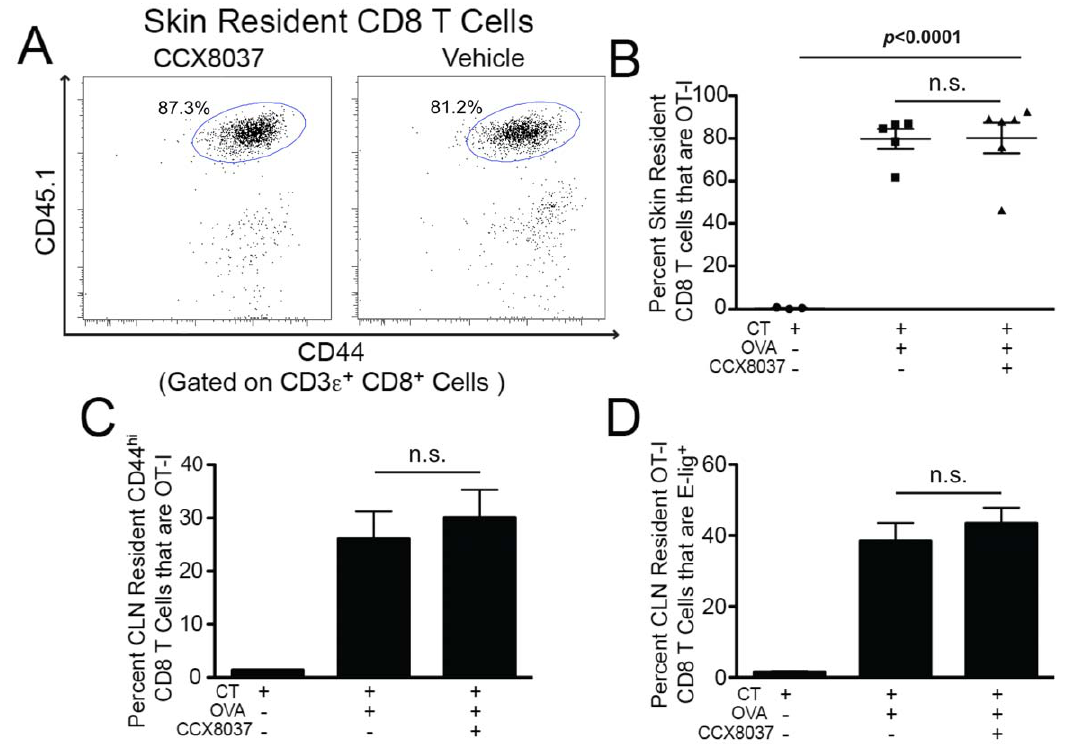
Figure 3. CCX8037 does NOT reduce accumulation of OT-I CD8 T cells in the skin. Animals were injected with 3e6 OT-I CD8 T cells, and epicutaneously immunized 24 hours later on the ear skin. Ear skin was painted with either 100 m g Cholera Toxin (CT) only, or 100 m g CT + 100 m g OVA 257–264 . Animals treated with OVA 257–264 were split into two groups and received subcut. injections of CCX8037 or vehicle every 12 hours for the course of the study. Mice were sacrificed for analysis 5 days post immunization. Mean and SEM shown for each data point, p values indicate Bonferroni multiple comparison post test. (A) Representative flow cytometry plot showing the accumulation of CD44 hi CD8 T cells, and gating of OT-I (CD45.1) cells in the ear skin. Plots are pre-gated on CD3 e + CD8 a + cells. (B) Quantification of OT-I CD8 T cell accumulation in ear skin. Mice treated with CT only did not exhibit substantial OT-I CD8 T cell homing into the ear skin. Mice treated CT + OVA 257-264 and treated with vehicle had significant OT-I CD8 T cell homing, with 79.6% of all resident CD8 T cells being OT-I derived, while those treated with CCX8037 had 80.2% of all CD8 T cells being OT-I derived. N=5 groups for vehicle, 6 for CCX8037 and 3 for CT only. Each group was comprised of 3–5 pooled mice. (C) CCX8037 did not affect the proliferation of OT-I CD8 T cells in CLN after Ag exposure. In animals exposed to CT only, OT-I CD8 T cells composed 1.4% of all CD44 hi CD8 T cells. In animals exposed to CT + OVA, there was no significant difference in the percentage of CD44 hi CD8 T cells that are OT-I between those treated with vehicle (26.0%) and CCX8037 (30.1%). N=3 groups for CT only treated mice, N=6 groups for Vehicle and CCX8037 treated mice, where each group is 3–5 pooled mice. (D) Generation of skin homing associated molecule E-selectin ligand by OT-I CD8 T cells in CLN was not affected by CCX8037. When mice were immunized with OVA antigen, the E-lig was not significantly affected by the presence of the CCX8037 (38.4% vehicle, 43.3% CCX8037). In the absence of OVA antigen, E-lig production by OT-I CD8 T cells was negligible ( , 1% E-lig + ). N=4 for CT only, 16 for Vehicle and CCX8037.